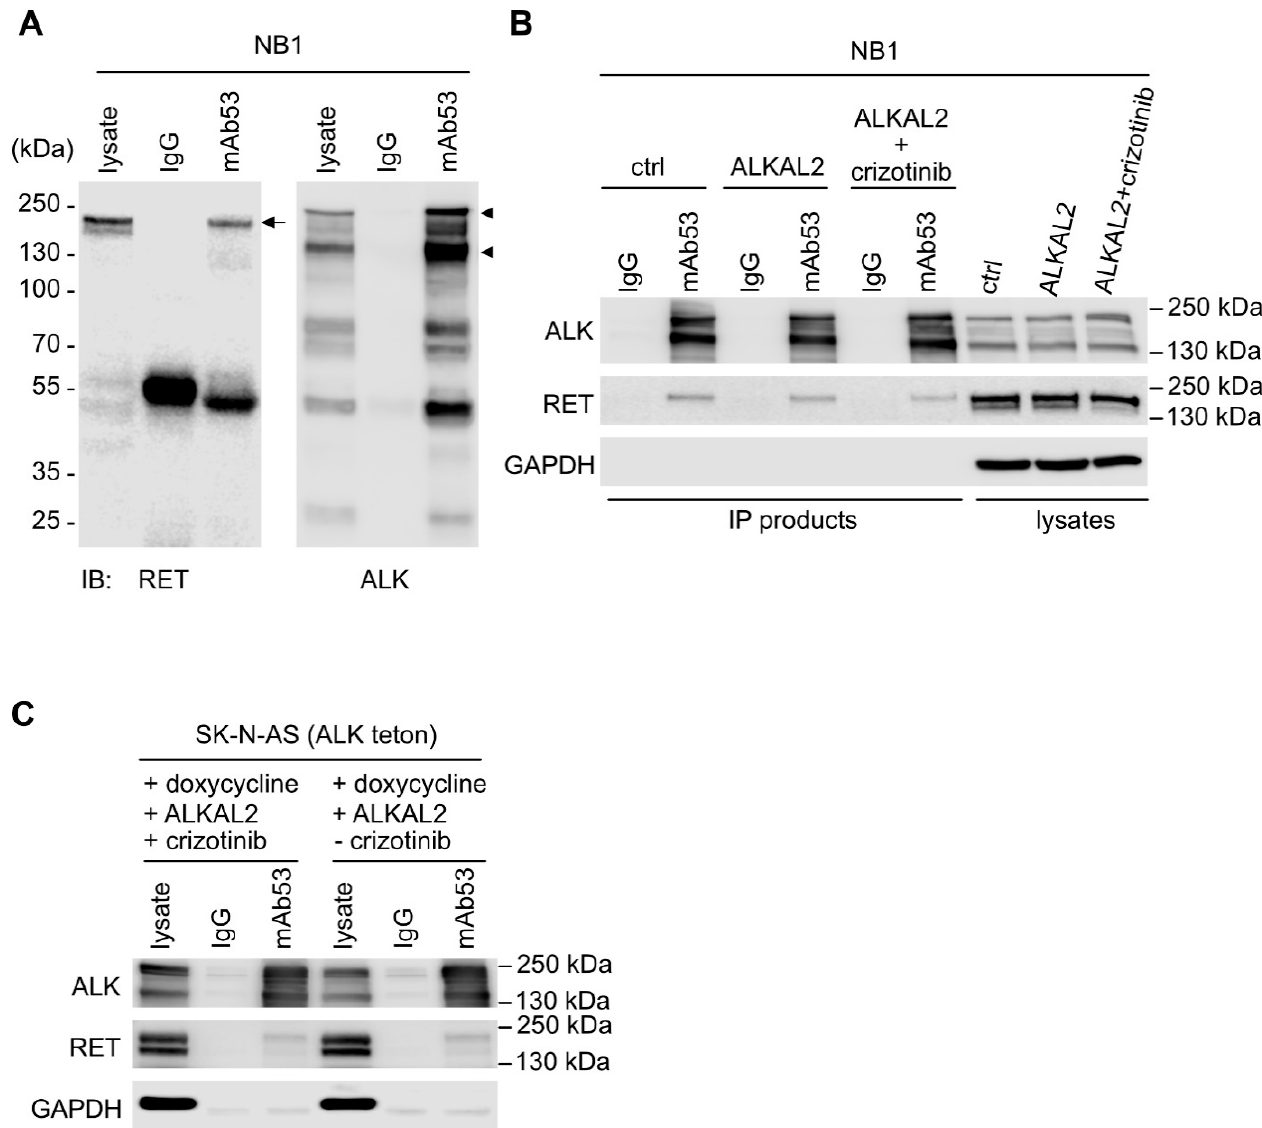
Figure 2. ALK interacts with RET. ( A ) Western blot analysis of ALK immunoprecipitation from NB1 cells, showing the presence of RET in ALK IP products. ( B ) The presence of RET in ALK IPs is not affected by ALK activity. Arrows indicate a slower-migrating form of RET that likely corresponds to surface RET protein; arrowheads highlight the 220 kDa and 140 kDa bands which correspond to full-length and cleaved ALK. House-keeping protein glyceraldehyde-3-phosphate dehydrogenase (GAPDH) was used as control. ( C ) Co-immunoprecipitation of RET with ALK in ALK-inducible SK-N-AS (ALK-teton) cells upon addition of doxycycline, independent of ALK activation.